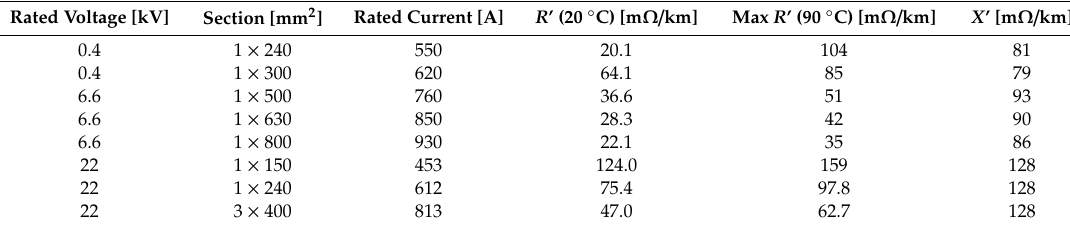
Table 5. Electrical data of the SSEN cables.